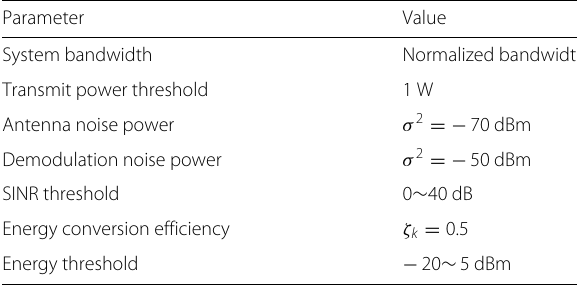
Parameter Value